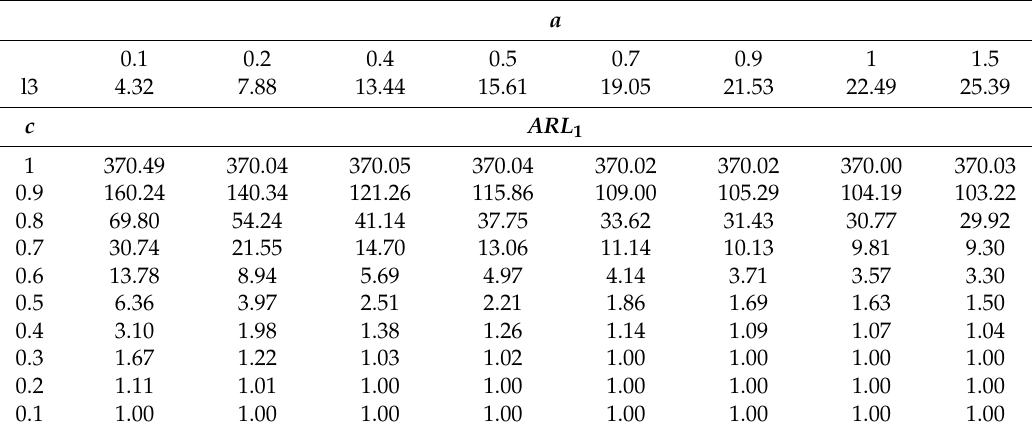
Table 3. The values of ARLs when r 0 = 370, β = 1, and µ 0 = 50.